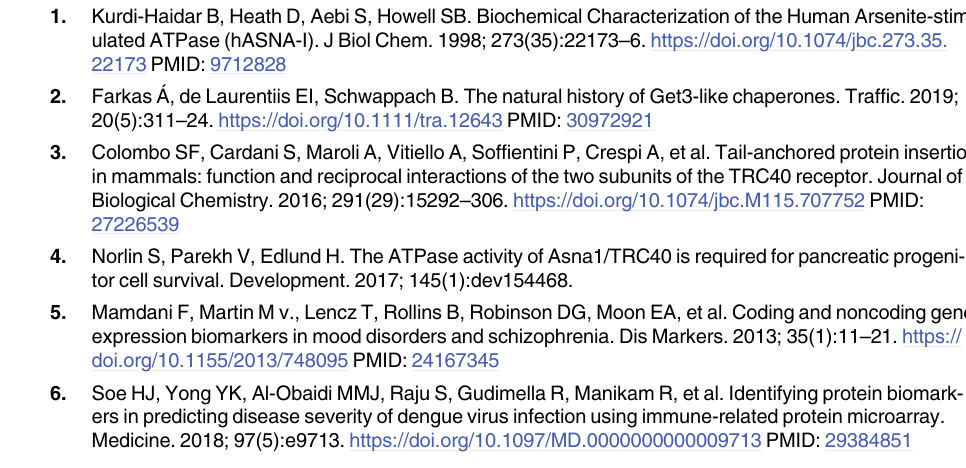
S2 Table. C . elegans strains used in this